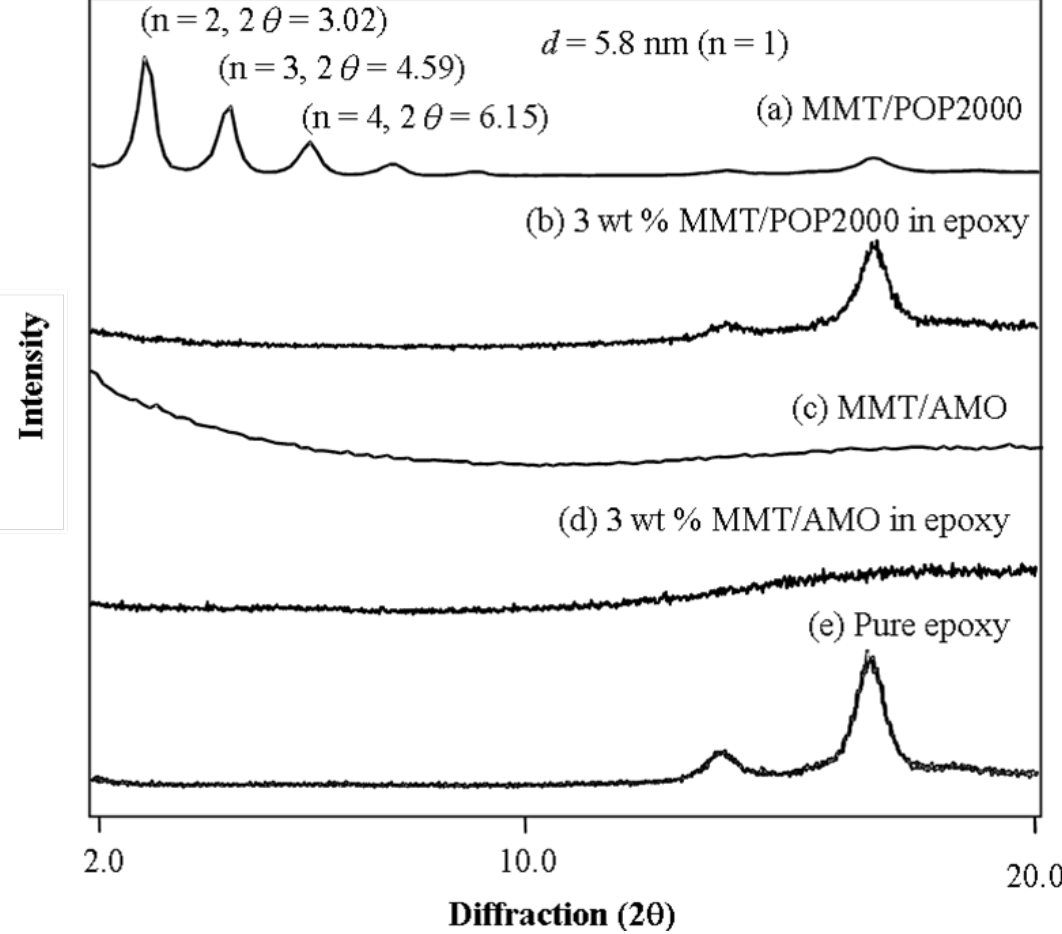
Figure 1. X-ray diffraction patterns of intercalated MMT/POP2000 and exfoliated MMT/AMO in cured epoxies (reprinted with permission from reference